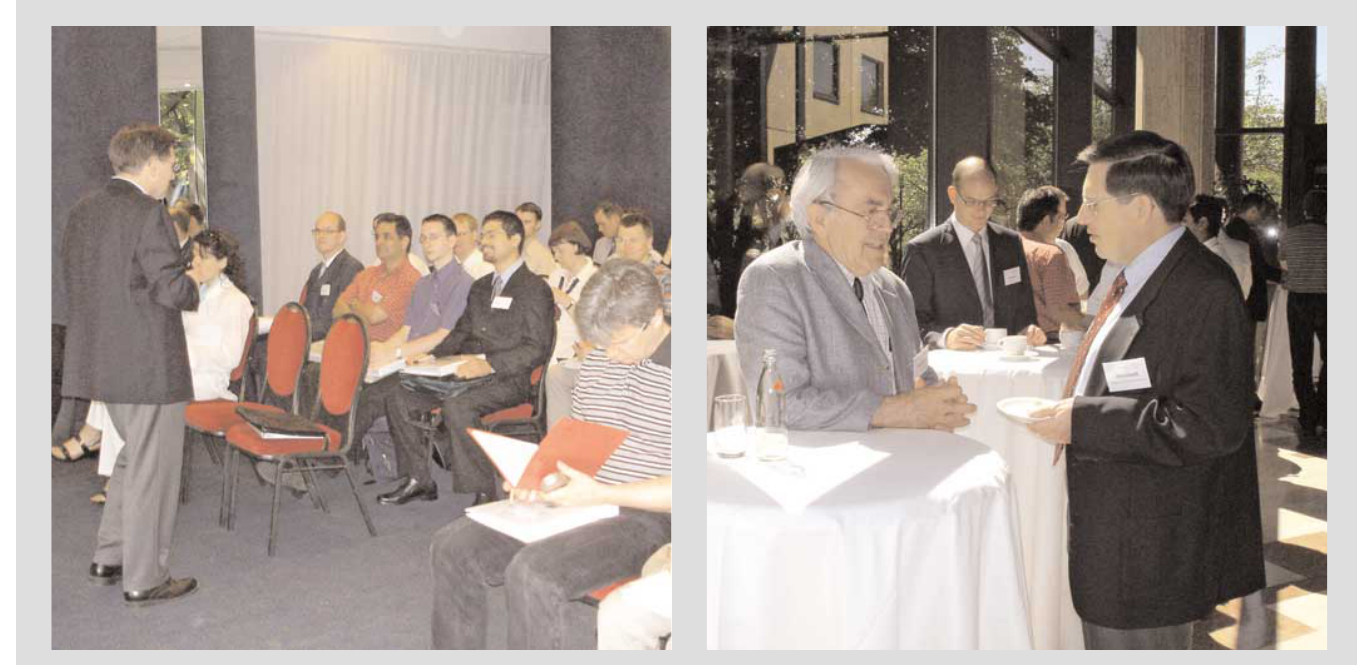
Figure 1 (left): Prof. Münstedt begrüsst die Teilnehmer. Figure 2: Lebhafte Diskussion in der